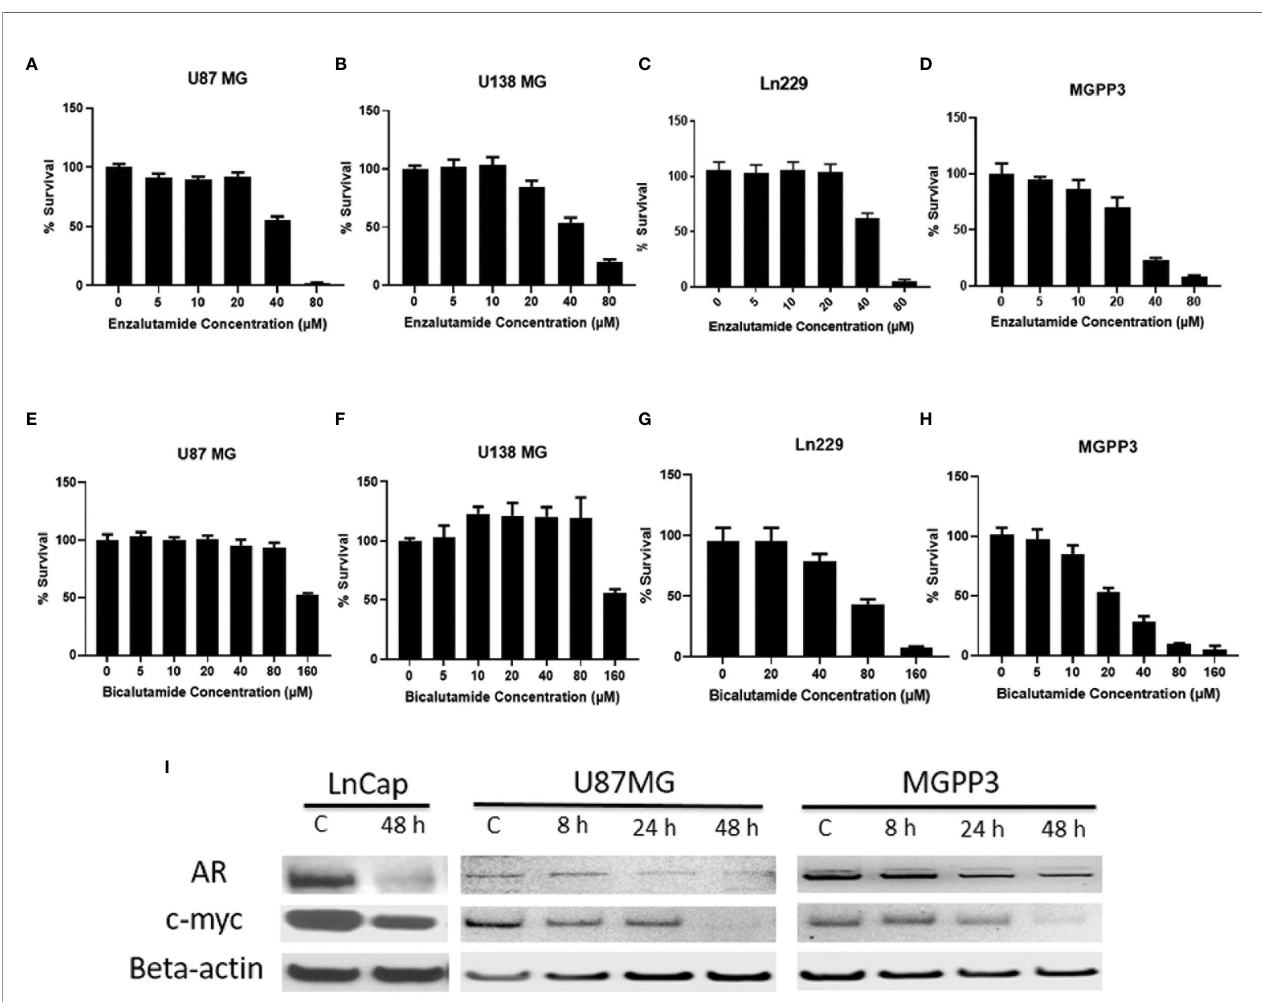
FIGURE 2 | AR antagonists inhibit proliferation of human and mouse GBM cell lines in vitro . (A – D) GBM cell lines were treated with indicated concentrations of enzalutamide for 2 days before cell titer blue assays were performed. (A) U87MG cell line (human) (IC50 = 41 m M). (B) U138MG cell line (human) (IC50 = 45 m M); (C) Ln229 cell line (human) (IC50 = 41 m M). (D) MGPP3 cell line (mouse) (IC50 = 56 m M); (E – H) GBM cell lines were treated with indicated concentrations of bicalutamide for 2 days before cell titer blue assays. (E) U87MG cell line (IC50 = 121 m M). (F) U138MG cell line (IC50 = 122 m M). (G) Ln229 cell line (IC50 = 72 m M). (H) MGPP3 cell line (IC50 = 42 m M). (I) Western blotting assays demonstrate that AR and c-Myc protein levels decrease in the U87MG, MGPP3 and LnCap cells (a prostate cancer cell line for positive control) after the treatment of enzalutamide (40 µM) time dependently. 8, 24, 48 h: cells were treated with the drug for 8, 24 or 48 h. All experiments were performed with three independent